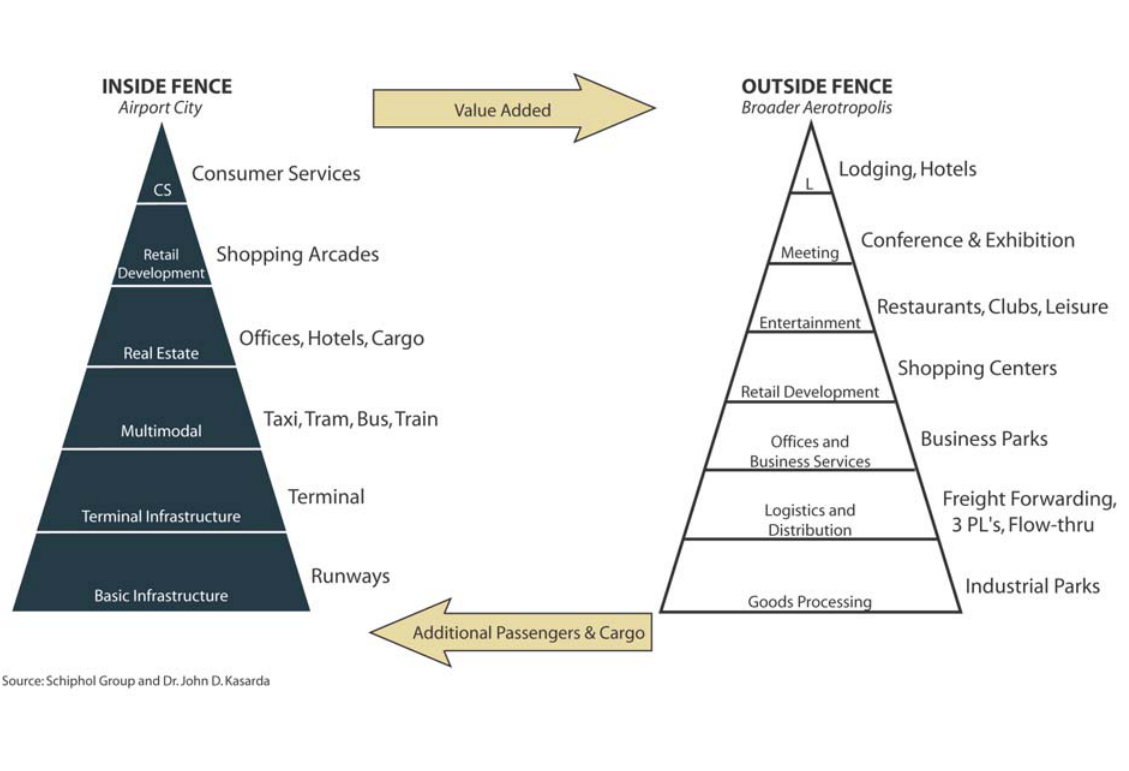
Figure 1. Added value activities in a wider airport concept source: Schiphol Airport and John Kasarda (2000) The Airport Council International (ACI), based on the information registered in their data bases estimates that in 1990 about 30% of airport revenues resulted from non-aeronautical activities. In 1995 the weight of non aeronautical revenues increased to 41%, in 2001 to 51% and in 2005 to 54%. Worth noticing is the airport of Atlanta, Hartsfield-Jackson, that in 2005 registered about 60% of non aeronautical